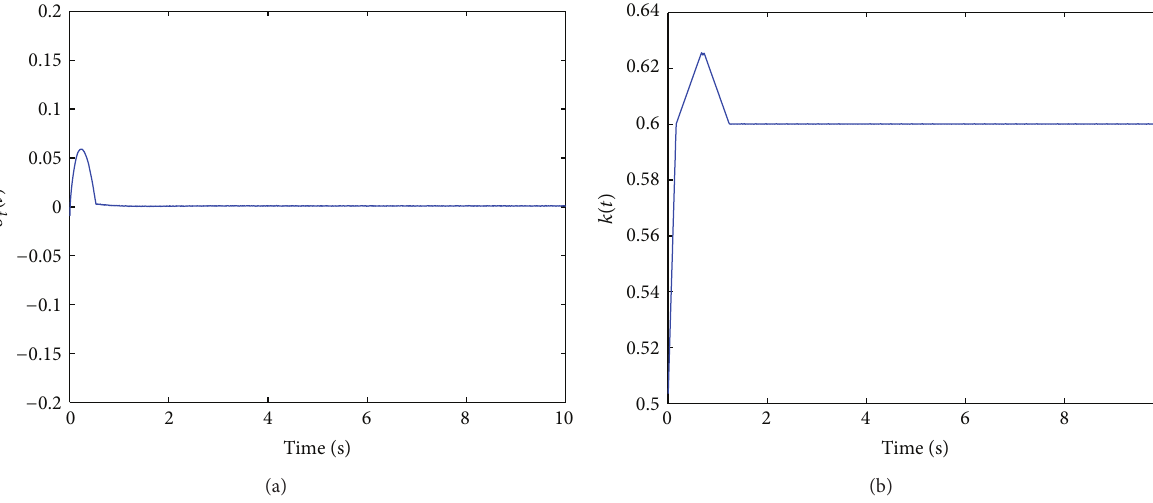
𝑤 is supposed to be a random noise possessing a mean value of 0.5 and |𝑤| ≤ 0.1